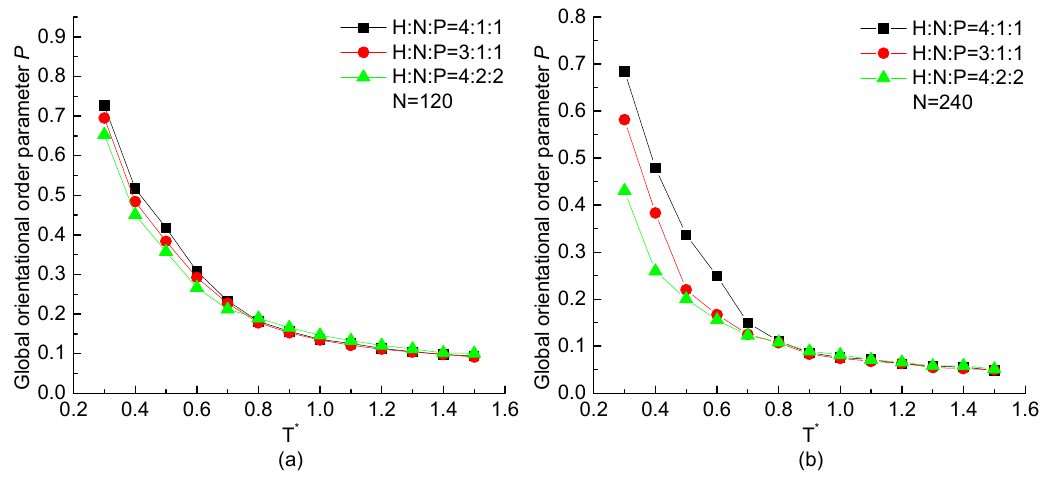
Figure 6. The global orientational order parameter P versus reduced temperature T * of H4N1P1, H3N1P1, and H4N2P2 with chain length of ( a ) N = 120, ( b ) N = 240 .